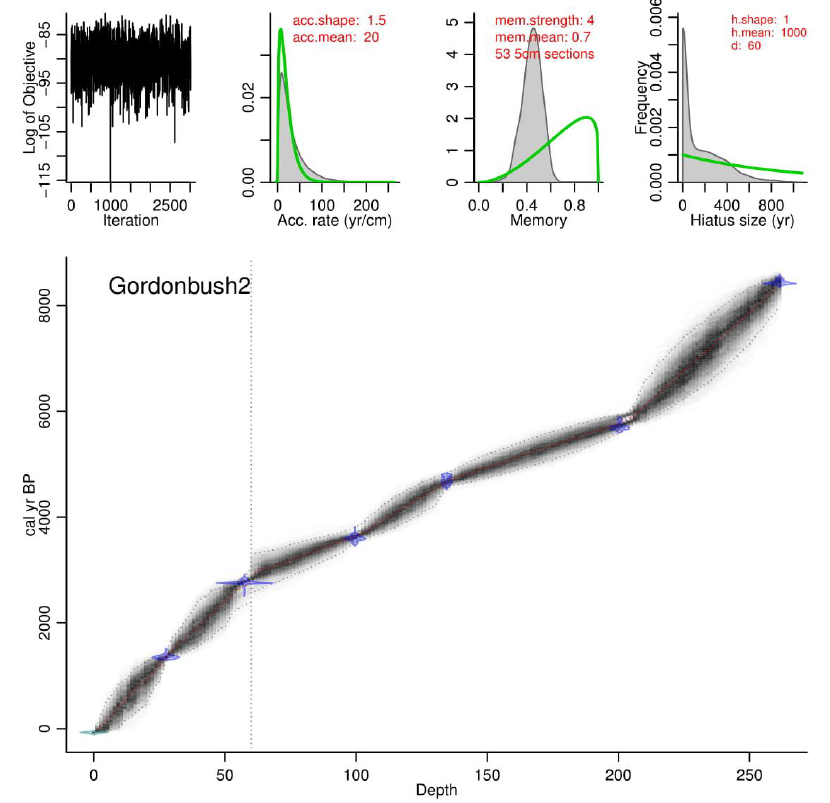
Figure A3j. Age-depth model produced in BACON for